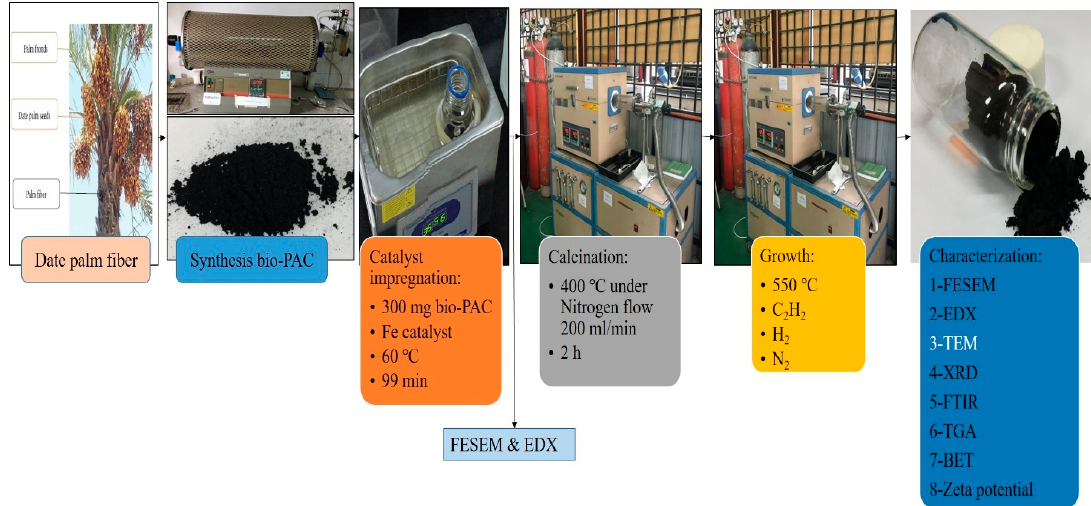
Figure 1. The preparation process for the synthesis of carbon nanotubes (CNTs).